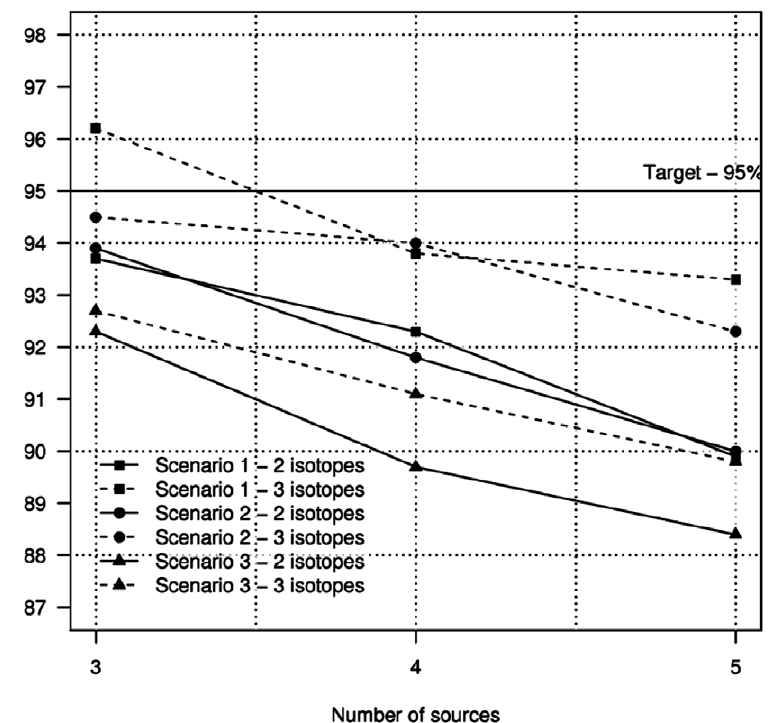
Figure 2. Proportion of 1000 simulated data sets where true values lie inside 95% intervals. The model performs well for all of the different scenarios considered. The figure shows the deterioration of model predictions as the number of sources is increased. Performance can be improved by increasing the number of isotopes used.